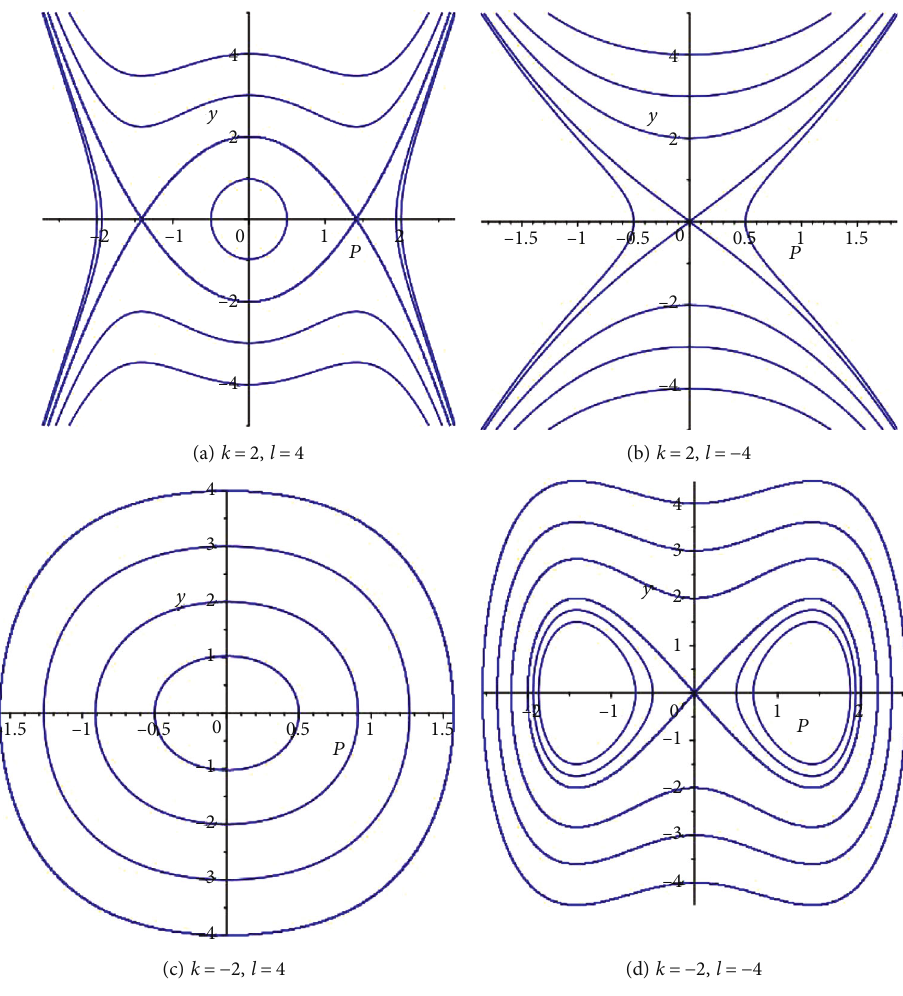
Figure 1: The phase portraits of system